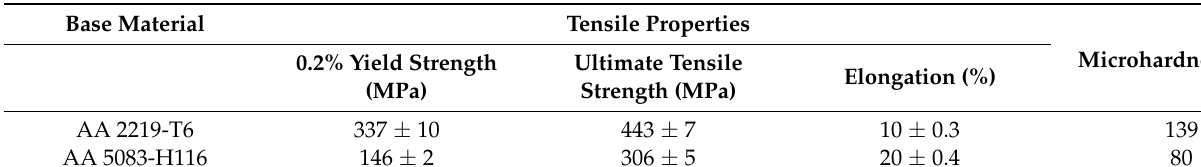
Table 2. Mechanical properties of base materials.